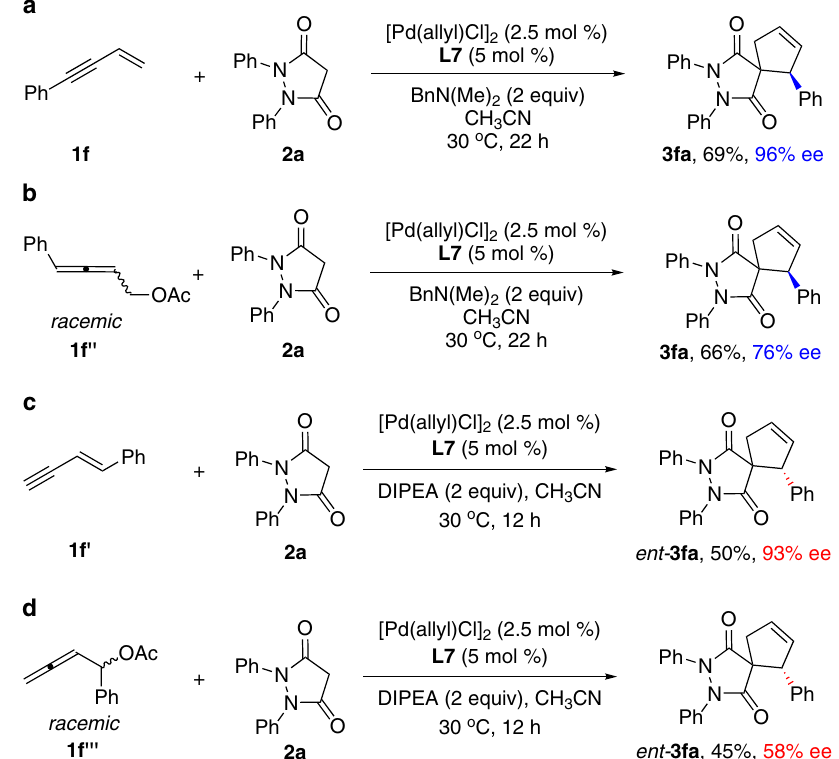
Fig. 8 Comparison experiments. a The cycloaddition of enyne 1f via the terminal Pd-butadienyl intermediate generated by PdH catalysis. b The cycloaddition of 2,3-allenyl acetate 1f ″ via the terminal Pd-butadienyl intermediate generated by oxidative addition. c The cycloaddition of enyne 1f ′ via the internal Pd-butadienyl intermediate generated by PdH catalysis. d The cycloaddition of 2,3-allenyl acetate 1f ‴ via the internal Pd-butadienyl intermediate generated by oxidative addition. DIPEA N,N